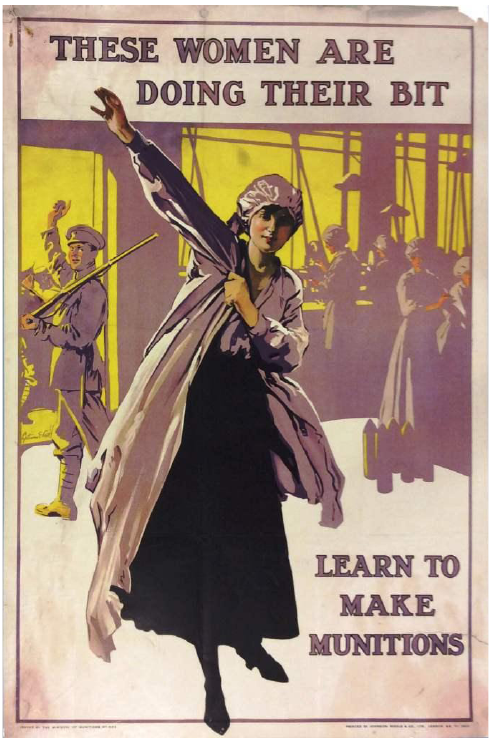
Figure 1. ‘These Women Are Doing Their Bit. Learn to Make Munitions’, poster designed by Septimus Scott. The National Archives of the UK, ref. EXT1/315